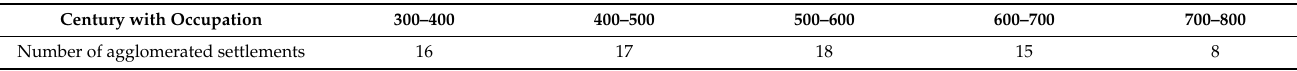
Table 2. Agglomerated settlement sites occupied during each